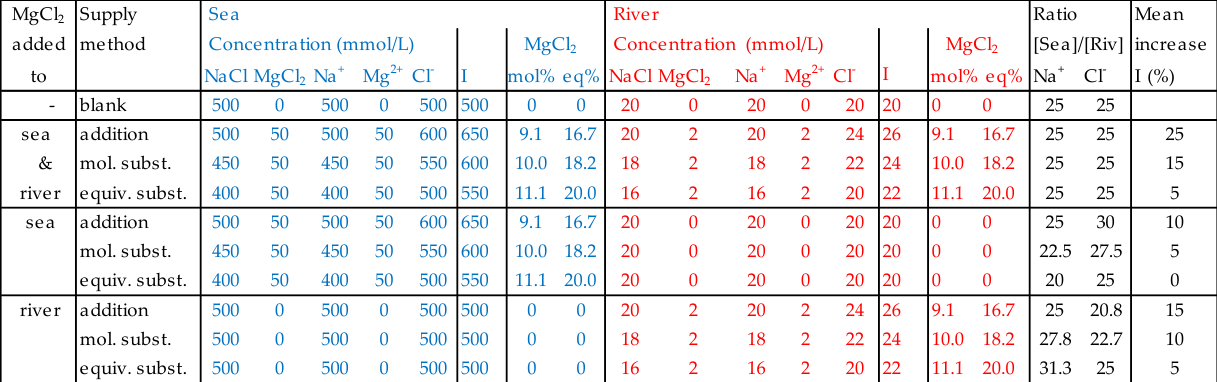
Figure 4. Experimental design for the determination of the effect of Mg 2+ on the power of a RED stack. I = ionic strength. In the most right column, the increase of the ionic strength in the sea and the river compartment are averaged.